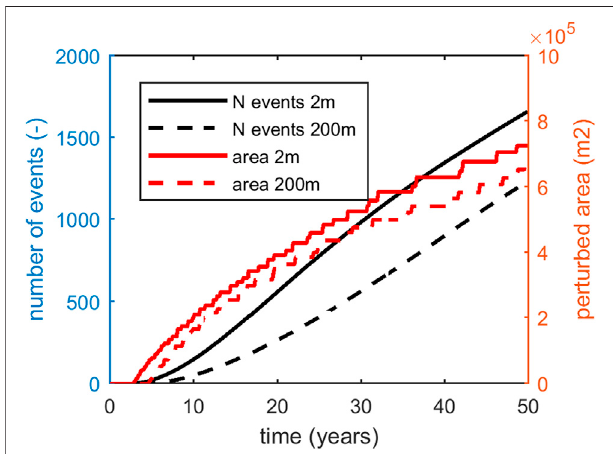
FIGURE 7 | Temporal evolution of perturbed area and total number of seismic events for the 2 and 200 m fracture spacing, in a low stress